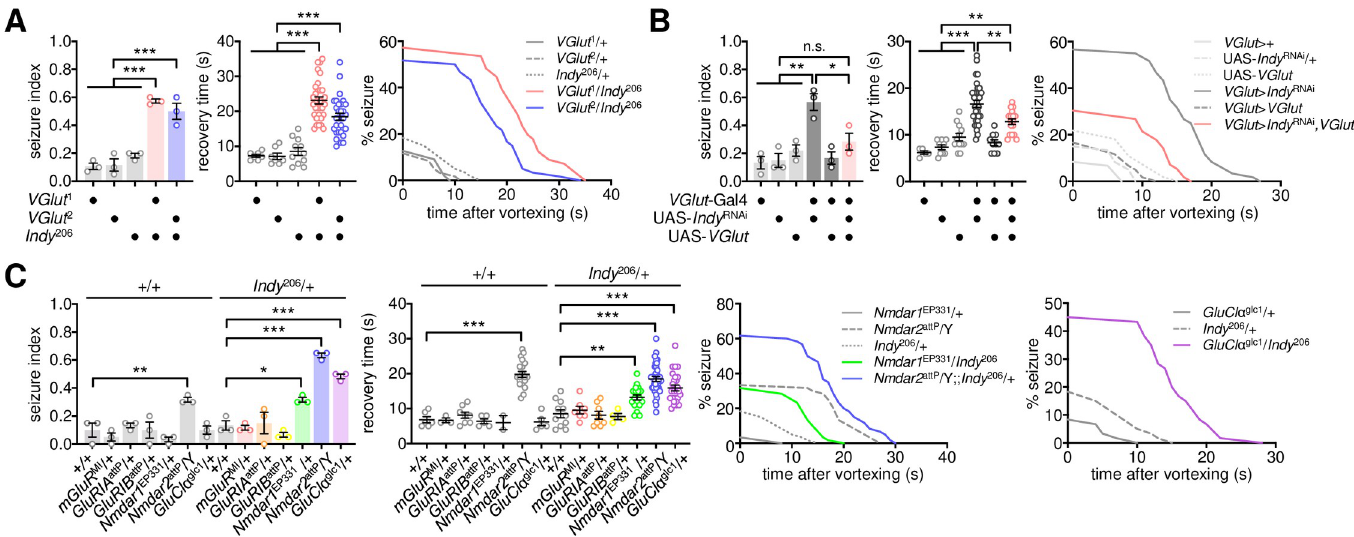
Fig 2. Down-regulation of glutamatergic transmission is responsible for Indy -dependent BSS. (A) Heterozygosity of VGlut induces BSS in heterozygous Indy mutants. Quantitative analyses of BSS in individual flies were performed as described in Fig 1. Data represent means ± SEM. ��� P < 0.001, as determined by one-way ANOVA with Holm-Sidak’s multiple comparisons test (seizure index, n = 55–60 flies in 3 independent experiments) or by Welch’s ANOVA with Dunnett’s multiple comparisons test (recovery time, n = 7–32 flies). (B) Overexpression of wild-type VGLUT suppresses BSS induced by transgenic depletion of INDY in glutamatergic neurons. Data represent means ± SEM (seizure index, n = 55–60 flies in 3 independent experiments; recovery time, n = 5–34 flies). n.s., not significant; � P < 0.05, �� P < 0.01, ��� P < 0.001, as determined by one-way ANOVA with Holm-Sidak’s multiple comparisons test. (C) Heterozygosity of ionotropic glutamate receptor Nmdar or GluCl α induces BSS in heterozygous Indy mutants. Significant Indy x glutamate receptor interaction effects on seizure index ( P = 0.0047 for Nmdar1 ; P = 0.0023 for Nmdar2 ; P = 0.0009 for GluCl α ) and recovery time ( P = 0.0136 for Nmdar2 ; P = 0.0049 for GluCl α ) were detected by two-way ANOVA. Data represent means ± SEM (seizure index, n = 60 flies in 3 independent experiments; recovery time, n = 2–37). � P < 0.05, �� P < 0.01, ��� P < 0.001, as determined by Holm-Sidak’s multiple comparisons test.